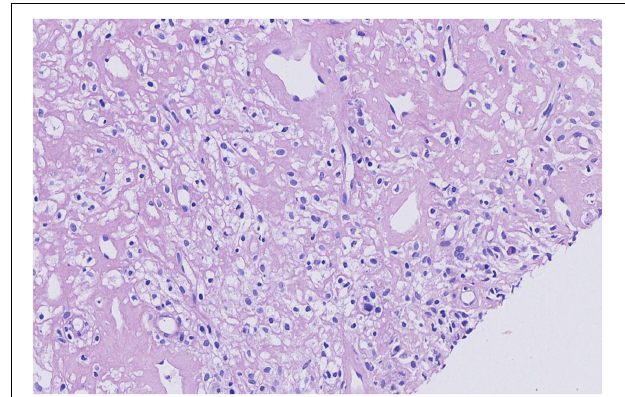
FIGURE 1 | Microscopic findings for the biopsied specimen before the chemotherapy regimen was chosen. T cell/histiocyte-rich large B cell